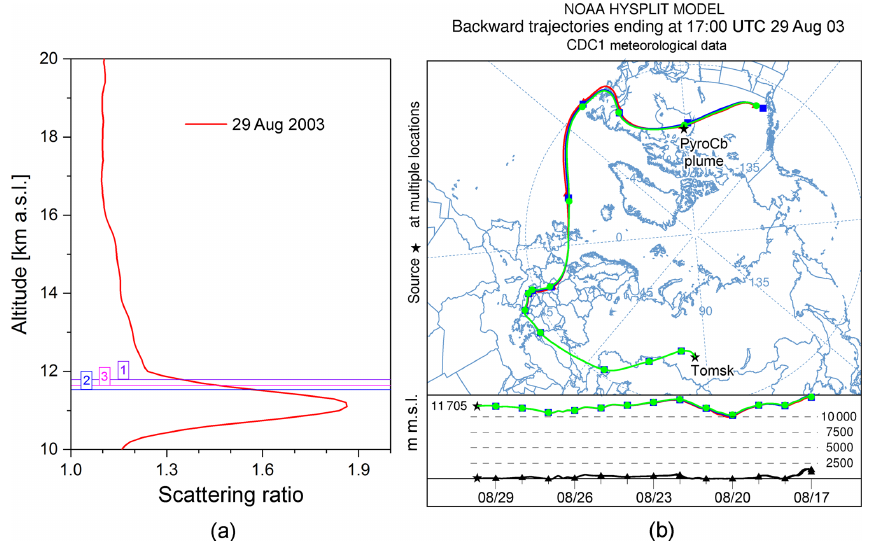
Figure 4. (a) Detection of the Conibear Lake Fire pyroCb plume in the UT–TR over Tomsk. The numbers 1–3 indicate the tropopause altitudes estimated in Kolpashevo, Emeljanovo, and Novosibirsk, respectively, at 17:00UTC on 29 August 2003. (b) Air mass backward ensemble trajectories started from altitude of ∼ 11 . 7km over Tomsk at the same